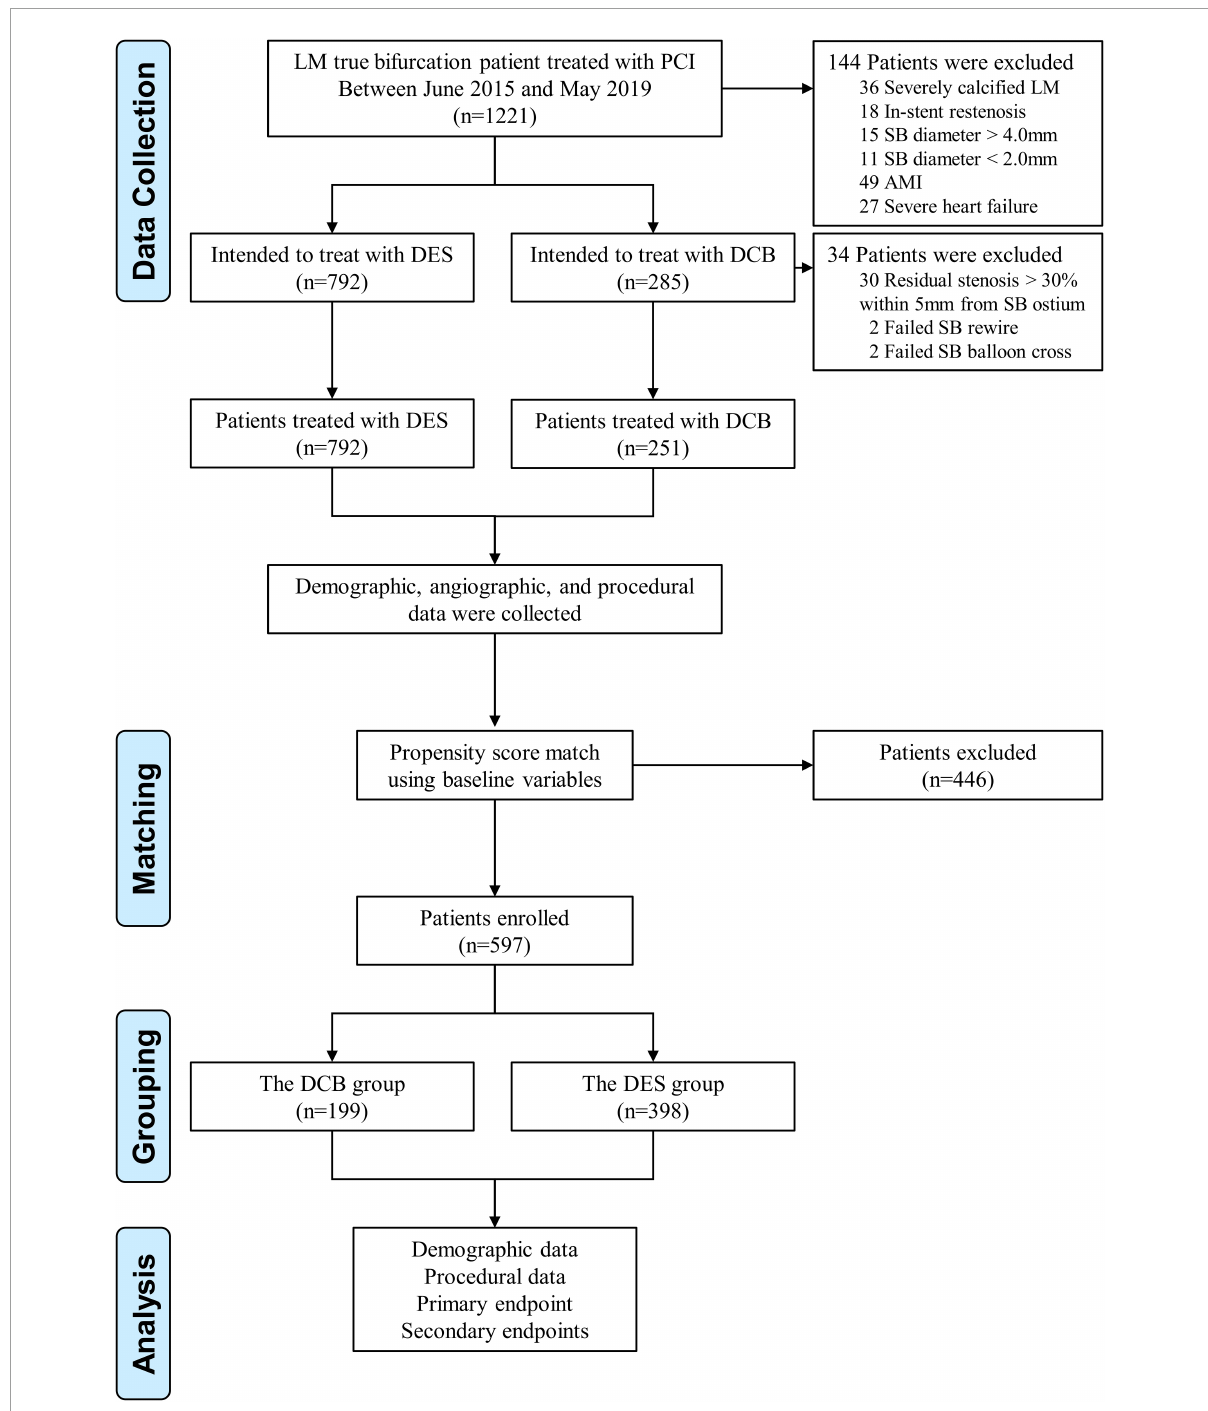
FIGURE1 Study population. LM, left main; PCI, percutaneous coronary intervention; SB, side branch; AMI, acute myocardial infarction; DCB, drug-coated balloon; DES, drug-eluting stent.